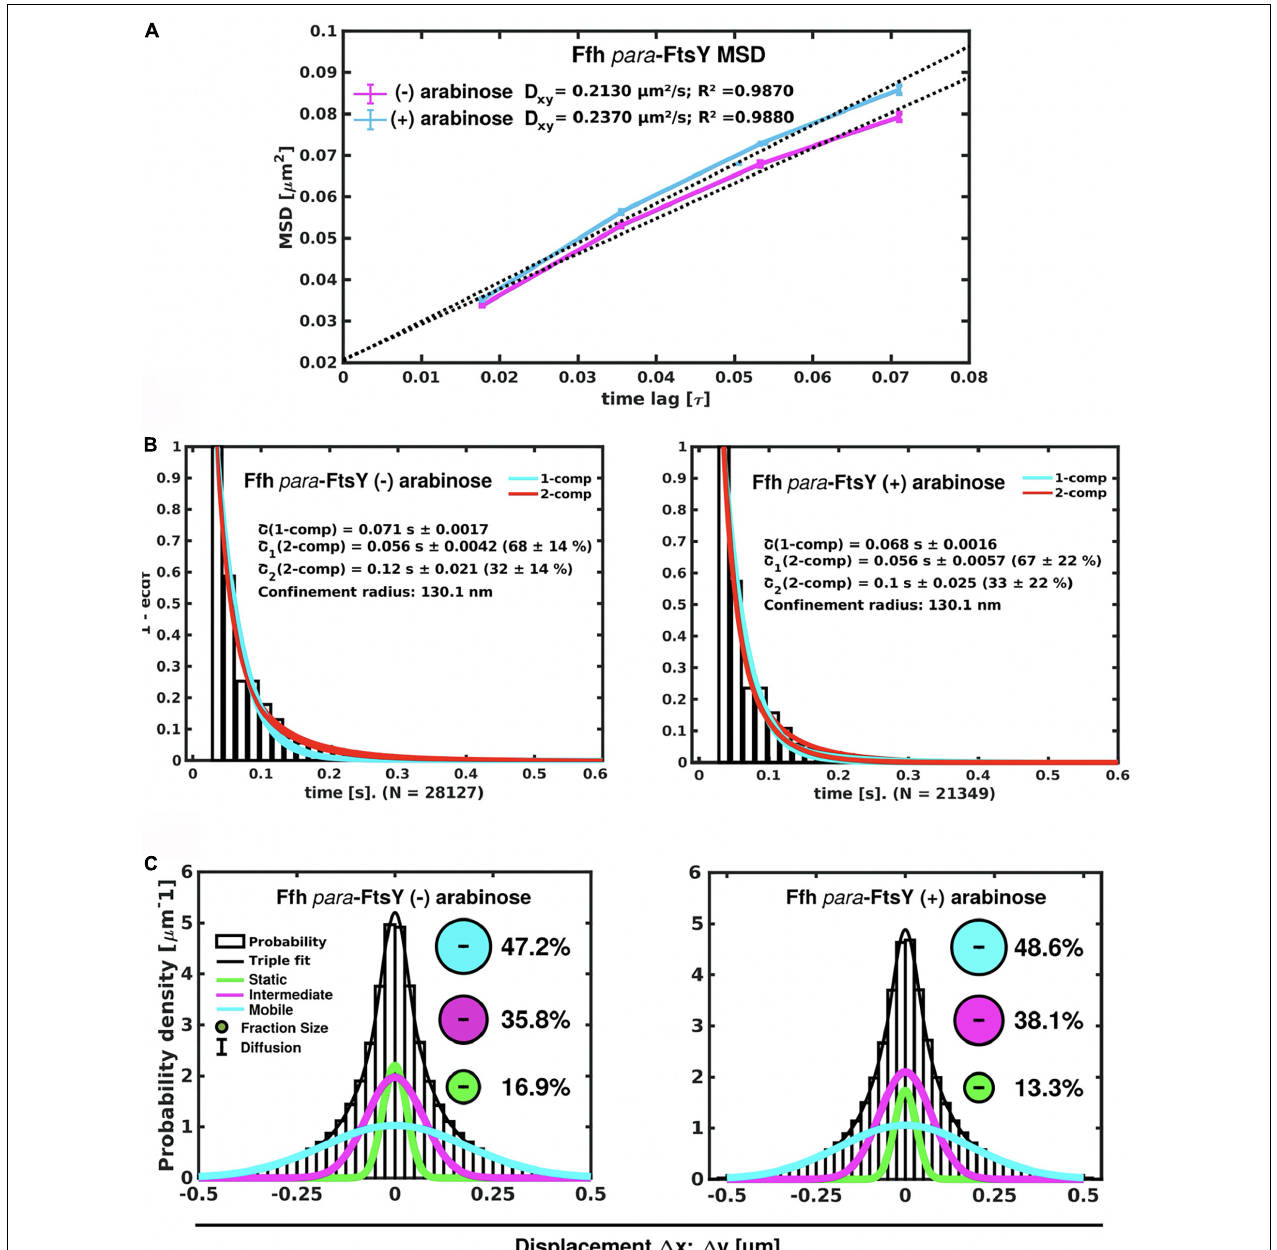
FIGURE 7 | Changes in Ffh dynamics in response to FtsY depletion. (A) MSD analysis reveals slightly reduced mobility after depletion of FtsY (“- arabinose”). (B) Minor changes in dwell times, determined using a 2 population decay curve, after FtsY depletion (Ffh becomes slightly more static), (C) GMM analyses show a small increase in static Ffh molecules after FtsY